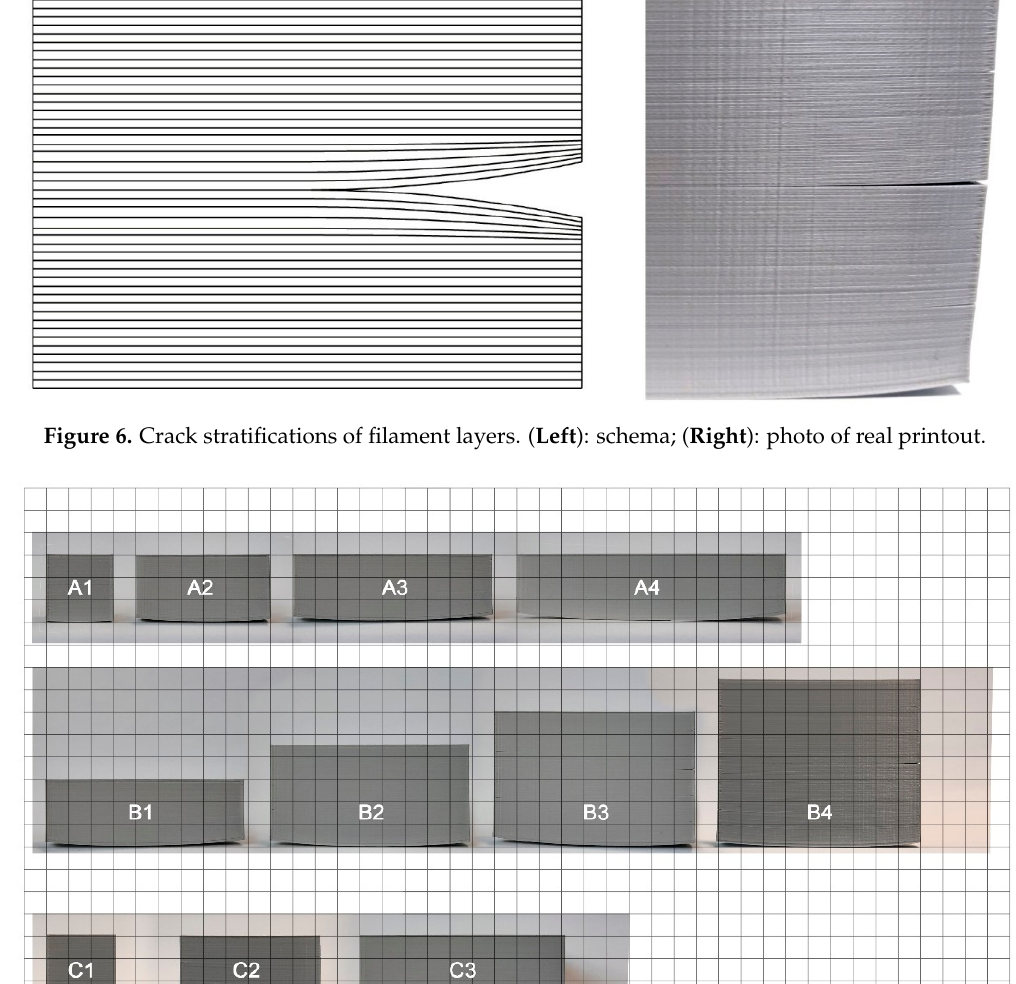
Figure 7. Photos of printed cubes for group A to C, placed on a 1 × 1 cm 2 grid.